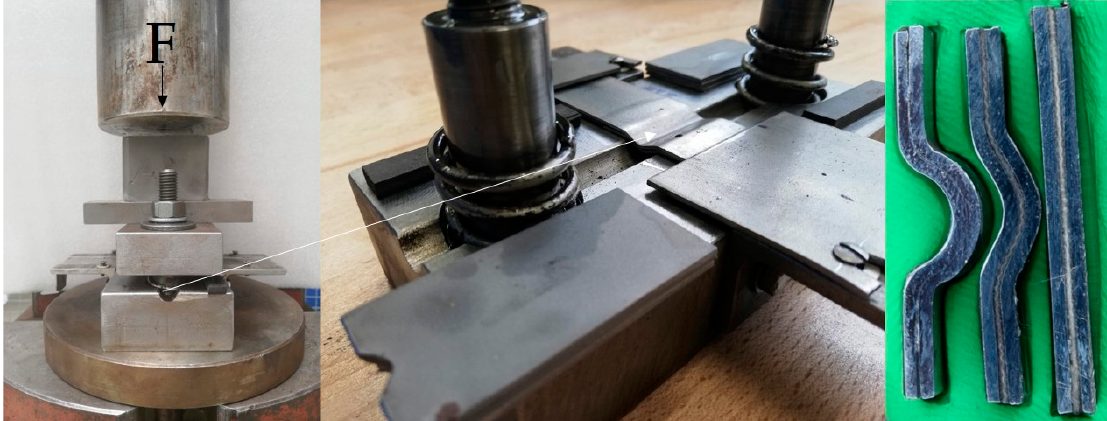
Figure 1. Pressing form for the shaping of adherends.